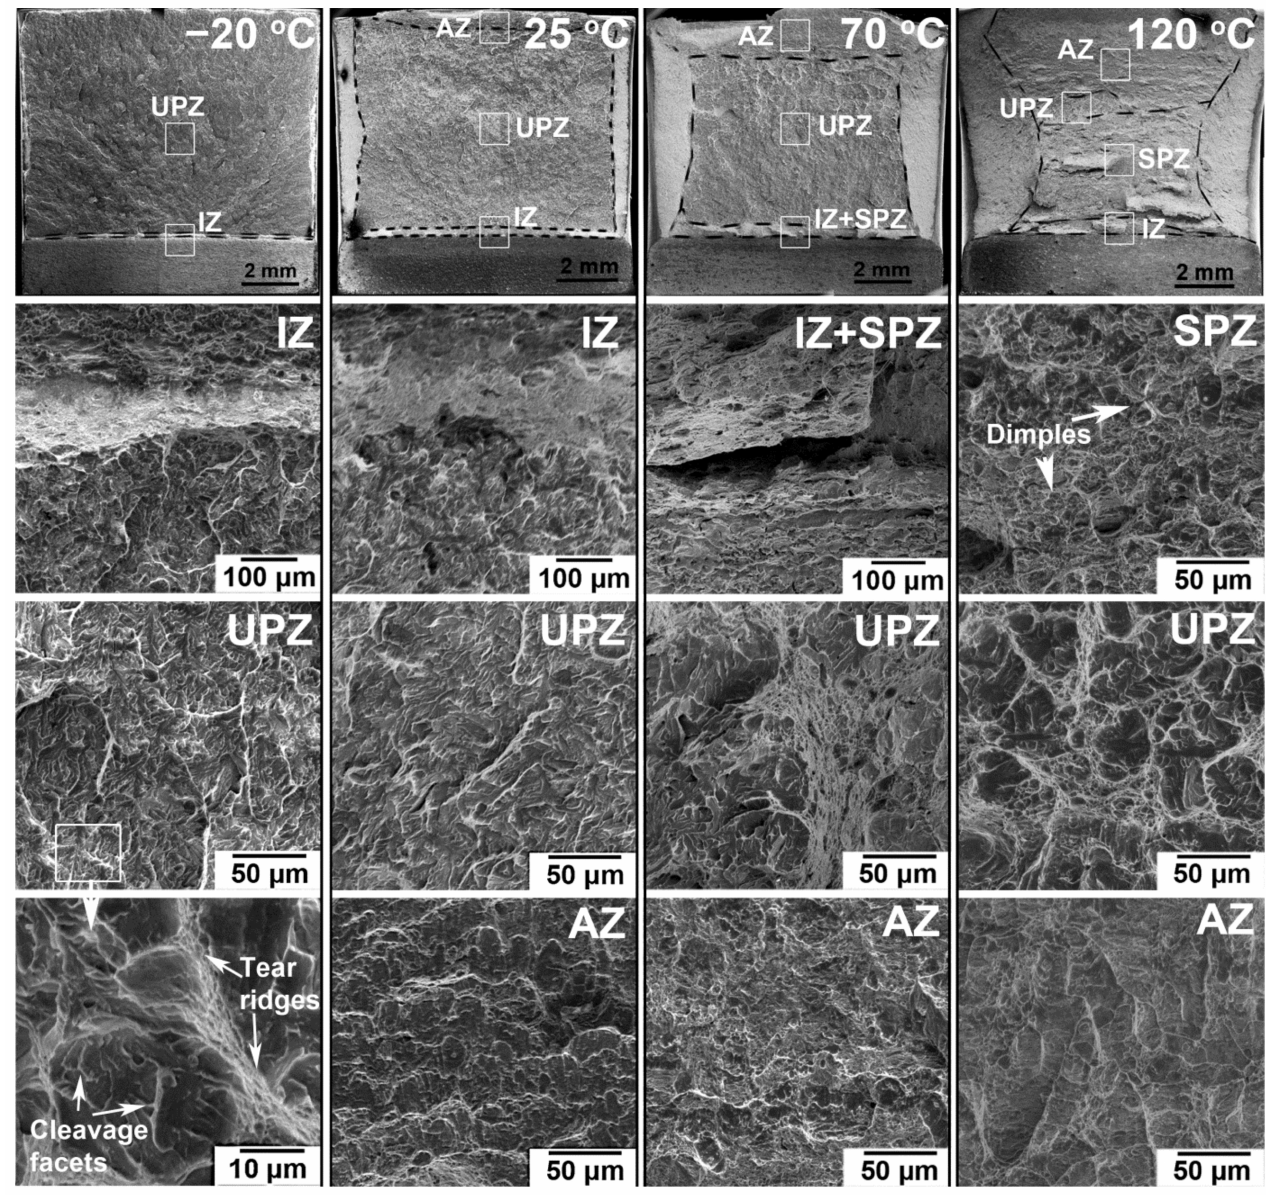
Figure 11. Fractography of the 12% Cr steel samples subjected to the CHT and the following impact tests at − 20 ◦ C, 25 ◦ C, 70 ◦ C, and 120 ◦